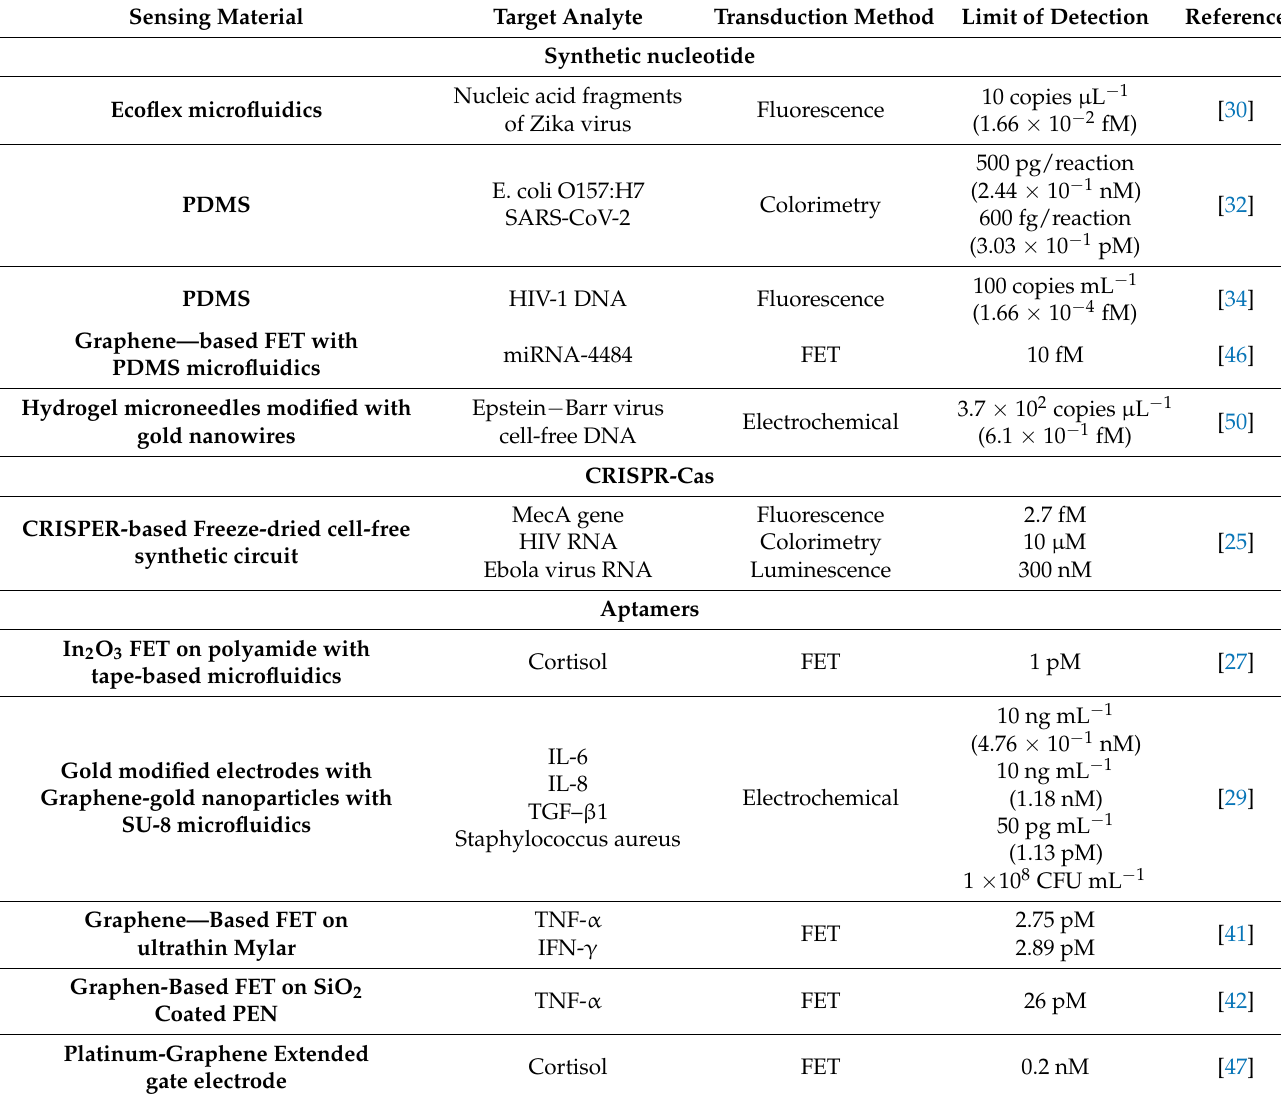
Table 1. Nucleic acid-based wearable